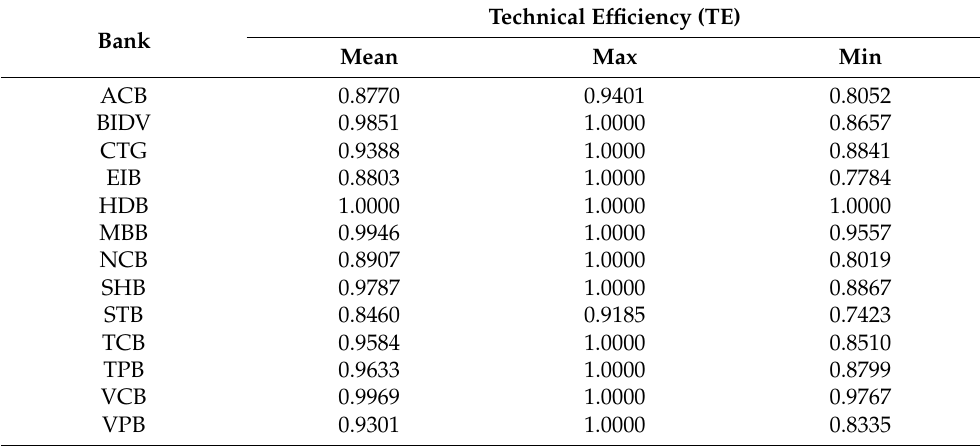
Table 2. Result of DEA analysis of commercial